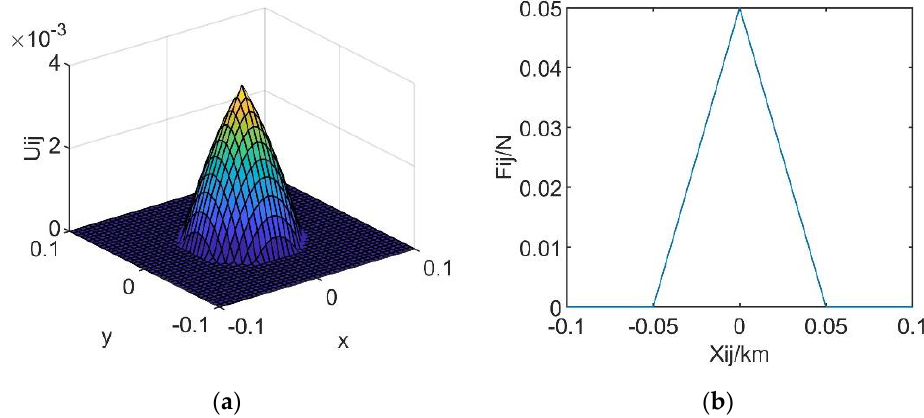
k s = = ). ( a ) Collision avoidance po- Figure 6. Collision avoidance potential field ( k c = 1 kg/s 2 , s = 0.05 km). ( a ) Collision avoidance Figure 6. Collision avoidance potential field ( 2 1kg s , 0.05km c potential function; ( b ) Collision avoidance control tential function; ( b ) Collision avoidance control force.